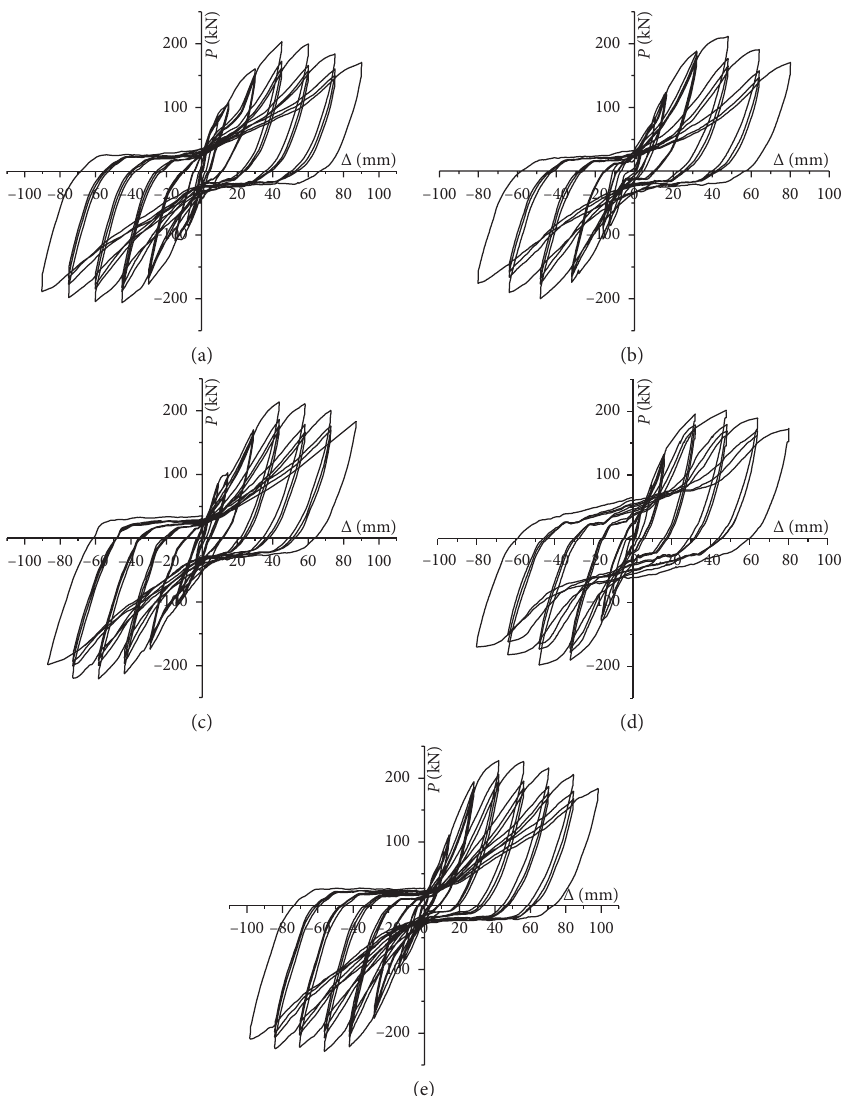
Figure 8: Load-displacement hysteretic curve. (a) J-1, (b) J-2, (c) J-3, (d) J-4, and (e)